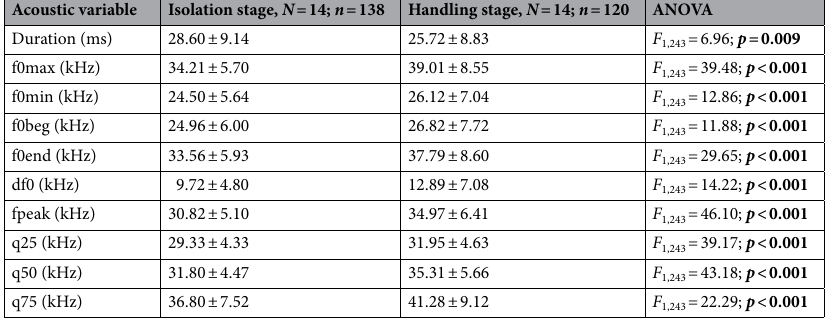
Table 4. Values (mean ± SD ) of the acoustic variables of single USVs without frequency jump and two-way ANOVA results for comparison between isolation and handling experimental stages. Animal individual identity was introduced in model as random factor. Designations as in Table